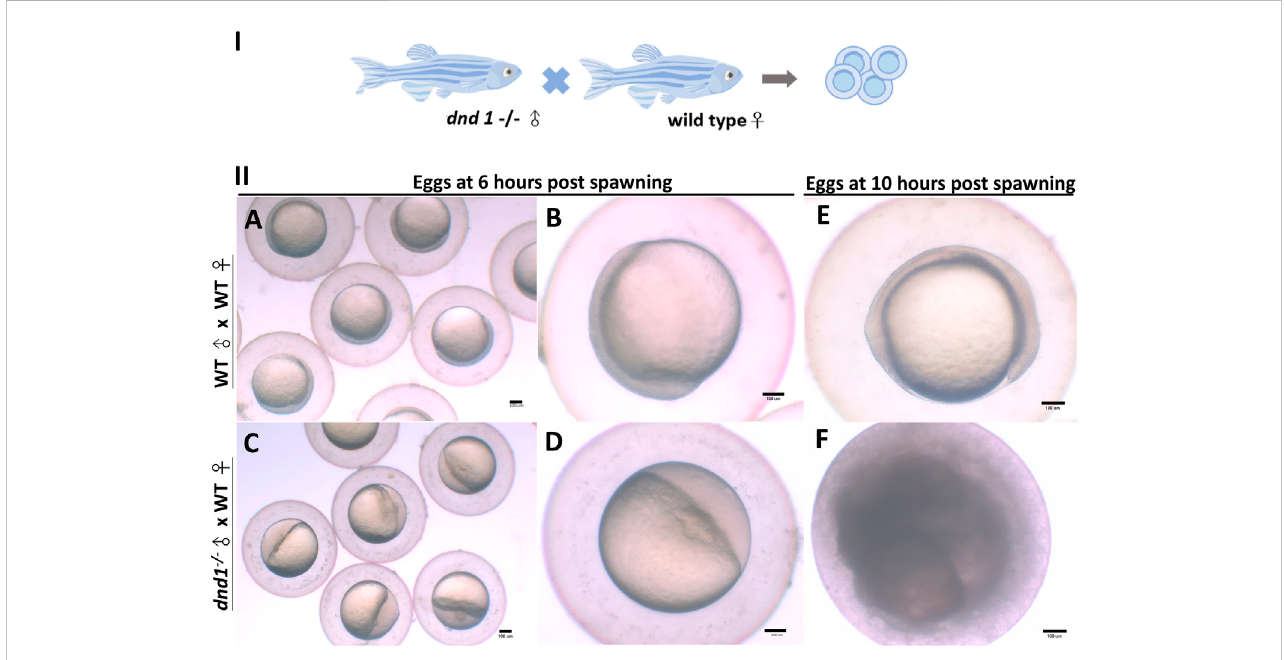
FIGURE 6 (I) dnd1 − / − zebra fi shwereallmale,withanormalcourtshipbehavior. (II) SpawnedeggsfromWTfemalematingwith dnd1 − / − maleandwild-typezebra fi sh.